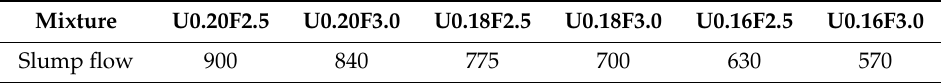
Table 4. Slump flow of the UHPC samples